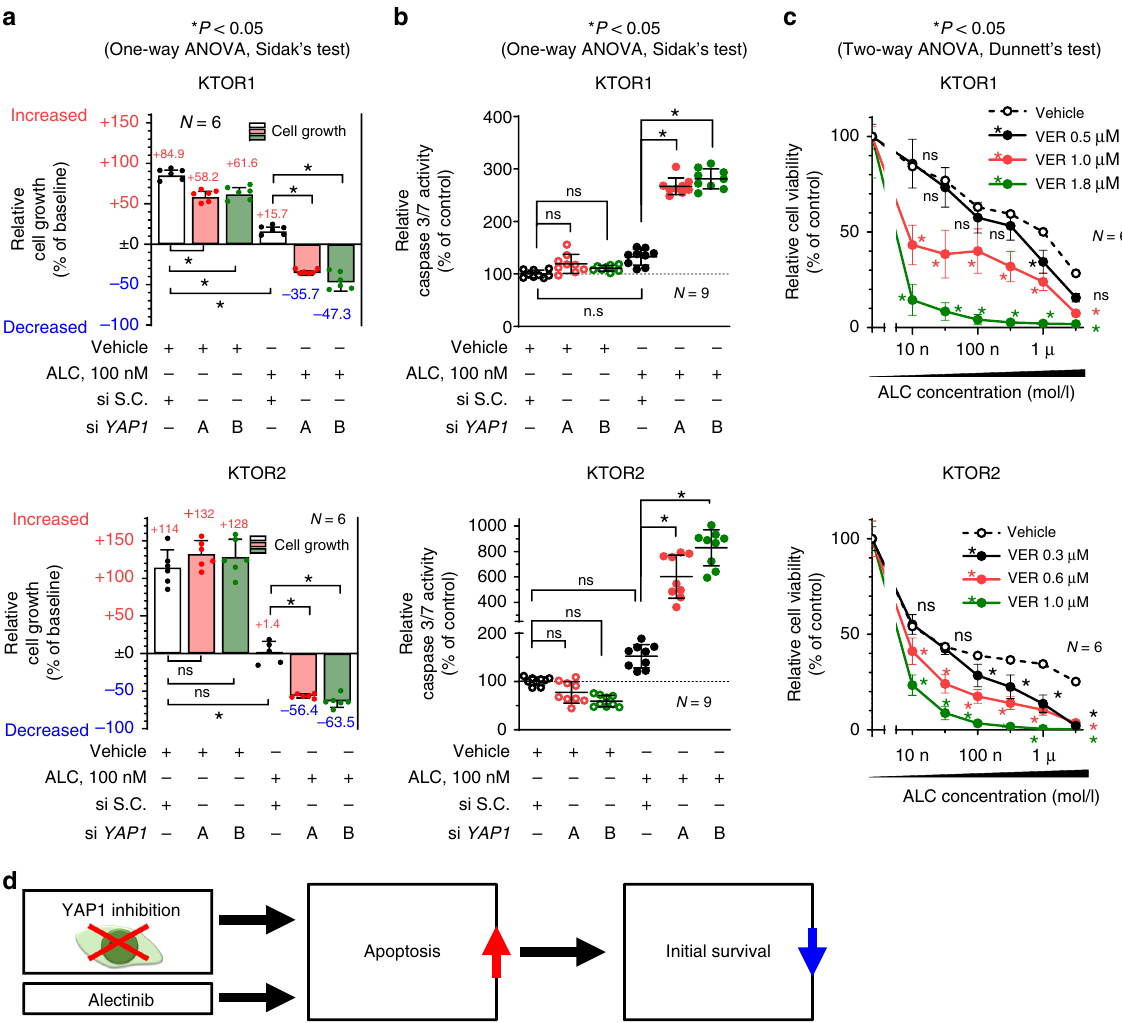
Fig. 4 YAP1 inhibition induced apoptosis and suppressed initial survival in ALK-rearranged cells. a Initial survival rates of KTOR1 and KTOR2 when cells were exposed to ALC or vehicle in combination with the knockdown of YAP1. Summarized results are shown in this panel. Signi fi cance was evaluated using a one-way ANOVA followed by Sidak ’ s multiple comparison test. Complete results, including H2228, are shown in Supplement Fig. 4a). b Apoptosis assay using Caspase-Glo ® in KTOR1 and KTOR2 cells exposed to ALC or vehicle in combination with the knockdown of YAP1. Signi fi cance was evaluated using a one-way ANOVA followed by Sidak ’ s multiple comparison test. Results for H2228 are shown in Supplementary Fig. 4b). c Cell viability assay for ALC exposure in KTOR1 and KTOR2 cells in the presence of VER, a YAP1 inhibitor. Signi fi cance was evaluated using a two-way ANOVA followed by Dunnett ’ s multiple comparison test. Results for H2228 are shown in Supplementary Fig. 4c). d Schematic explanation of the results in this Figure. The inhibition of YAP1 induced apoptosis and reduced initial survival when ALK-rearranged lung cancer was treated with ALC. ALC: alectinib, S.C. scramble control, VER vertepor fi n. Error bars indicate ± S.D. * P <